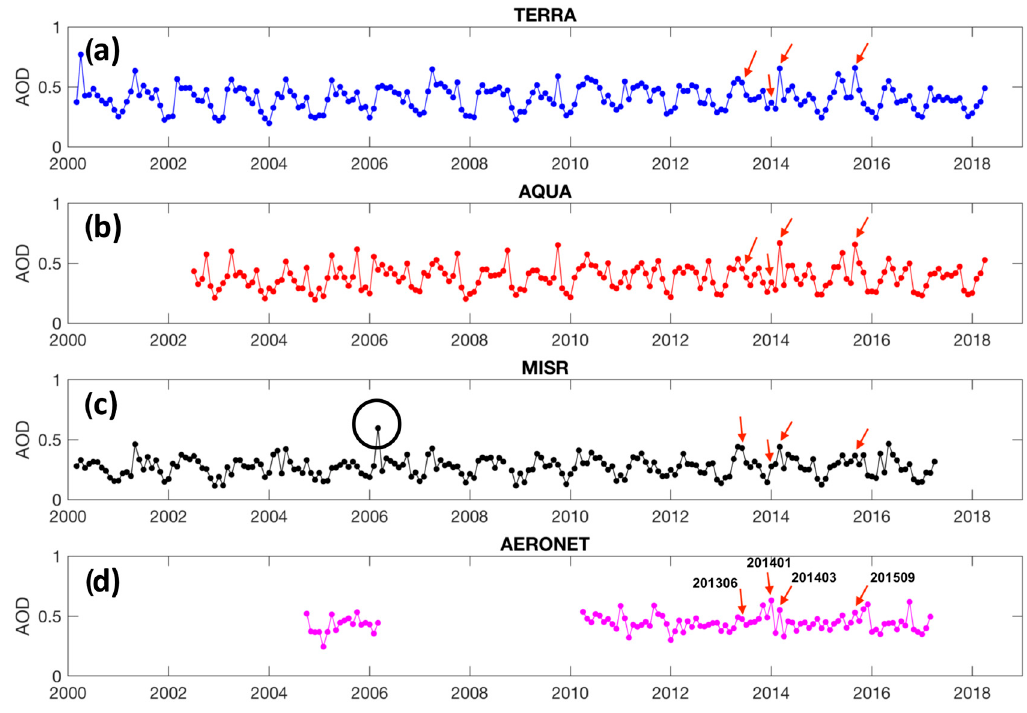
Figure 3. Time series plot of AOD in Cairo during 2000 to 2018 for ( a ) Terra MODIS, ( b ) Aqua MODIS, ( c ) MISR, and ( d ) AERONET, respectively. Red arrows point to the high AOD anomalies indicated during June 2013 (summer), January 2014 (winter), March 2014 (spring), and September 2015 (fall).